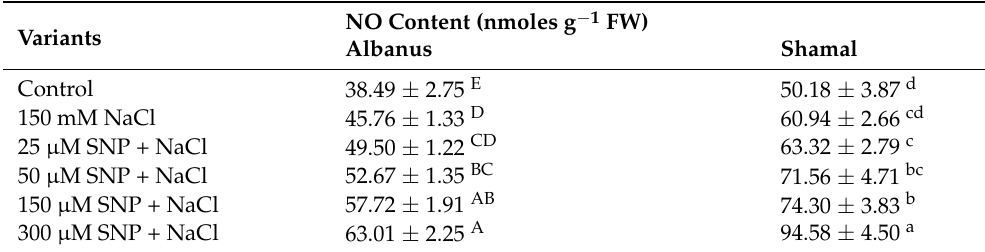
Table 1. NO content in leaves of two sorghum varieties (Albanus and Shamal) after treatment with different SNP concentrations and 150 mM